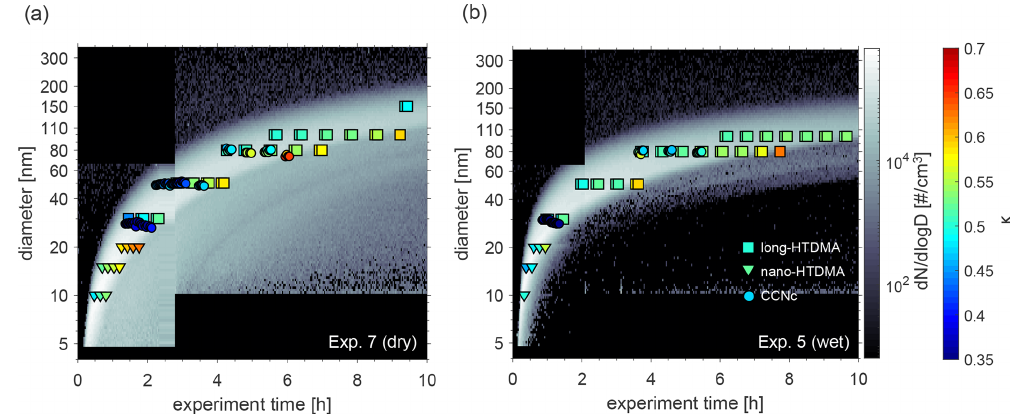
Figure 2. κ values as obtained from nano- (triangles) and long-HTDMA (squares) and from CCNc (circle) measurements for different dry particle sizes. Particle number size distributions of the DMS-derived aerosol particles at dry and wet conditions are shown in the background. Results are from (a) Exp. 7 (dry) and (b) Exp. 5